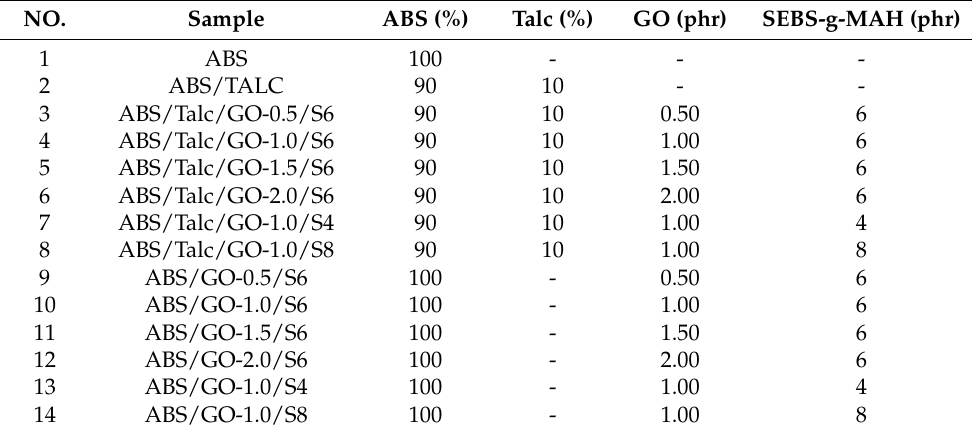
Table 1. Various compounding formulations of